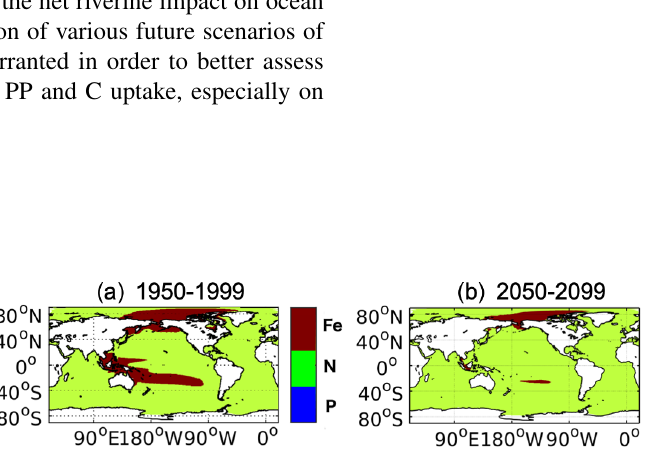
Figure A1. The limiting nutrient among iron, nitrate, and phosphate in REF during (a) 1950–1999 and (b) 2050–2099.